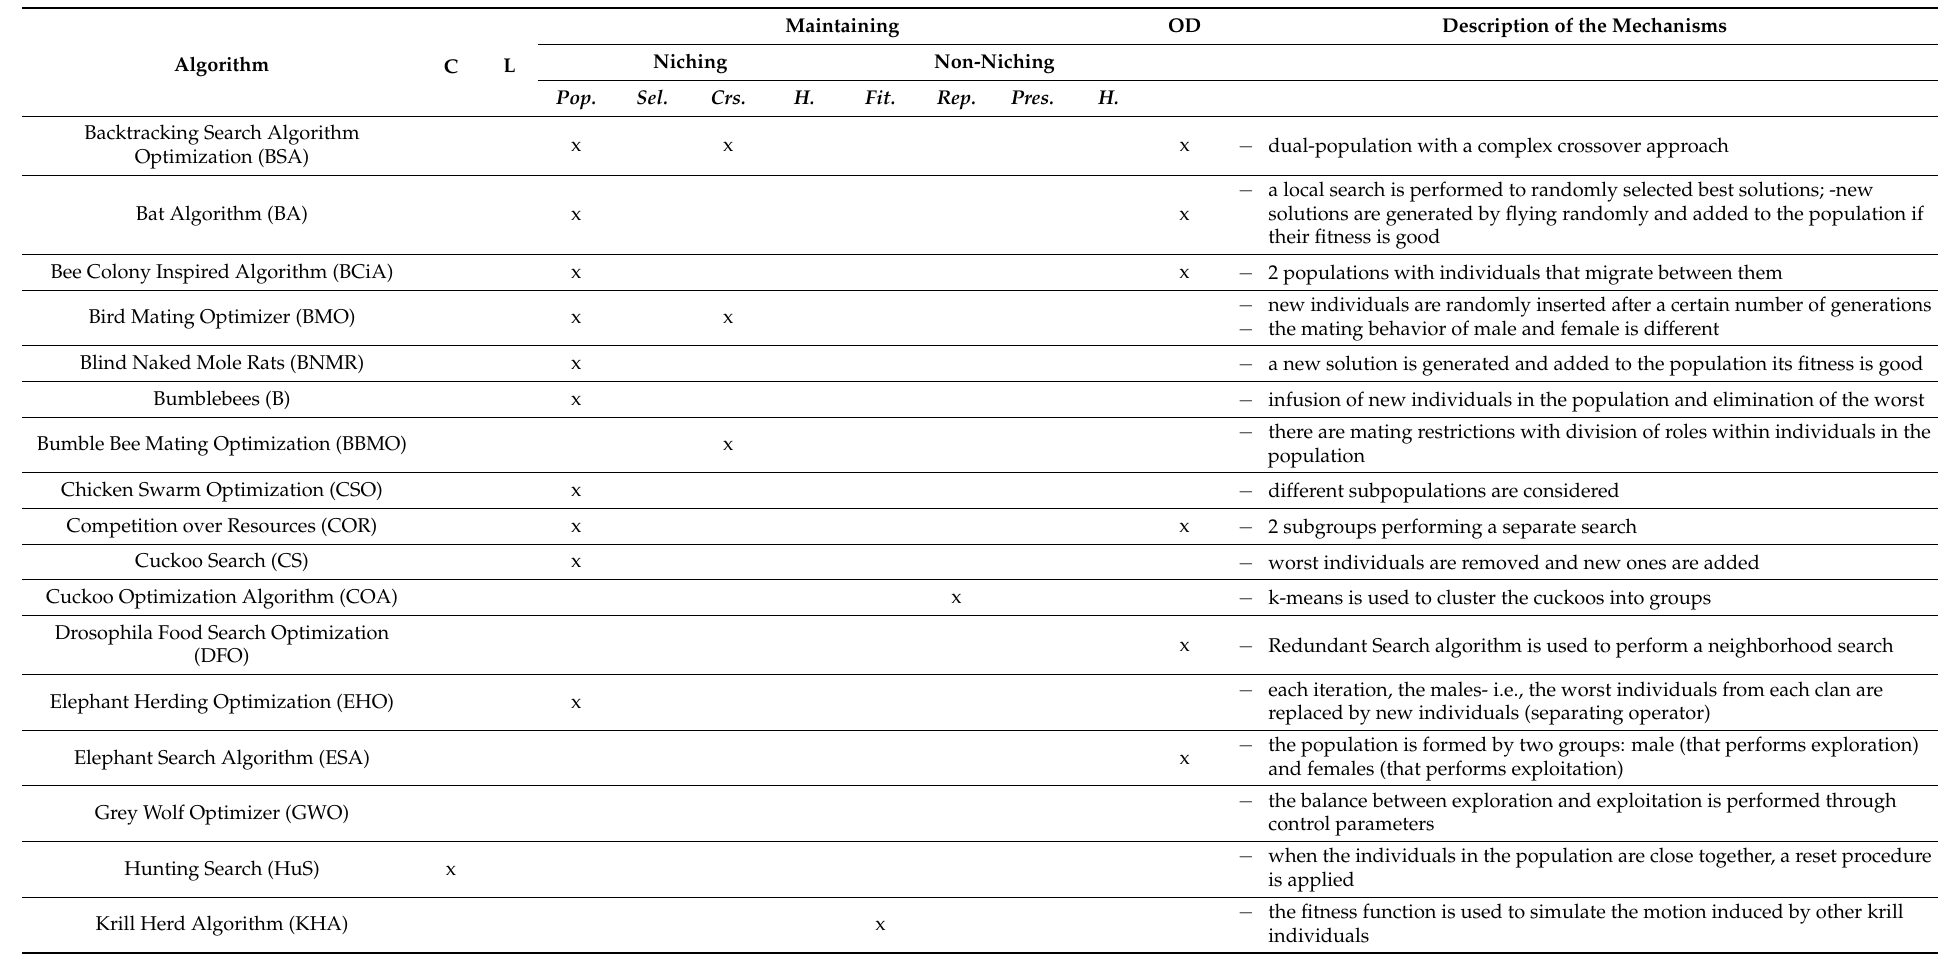
Table 6. The diversity-based approaches used for EEB by the bio-inspired metaheuristic optimizers (alphabetically